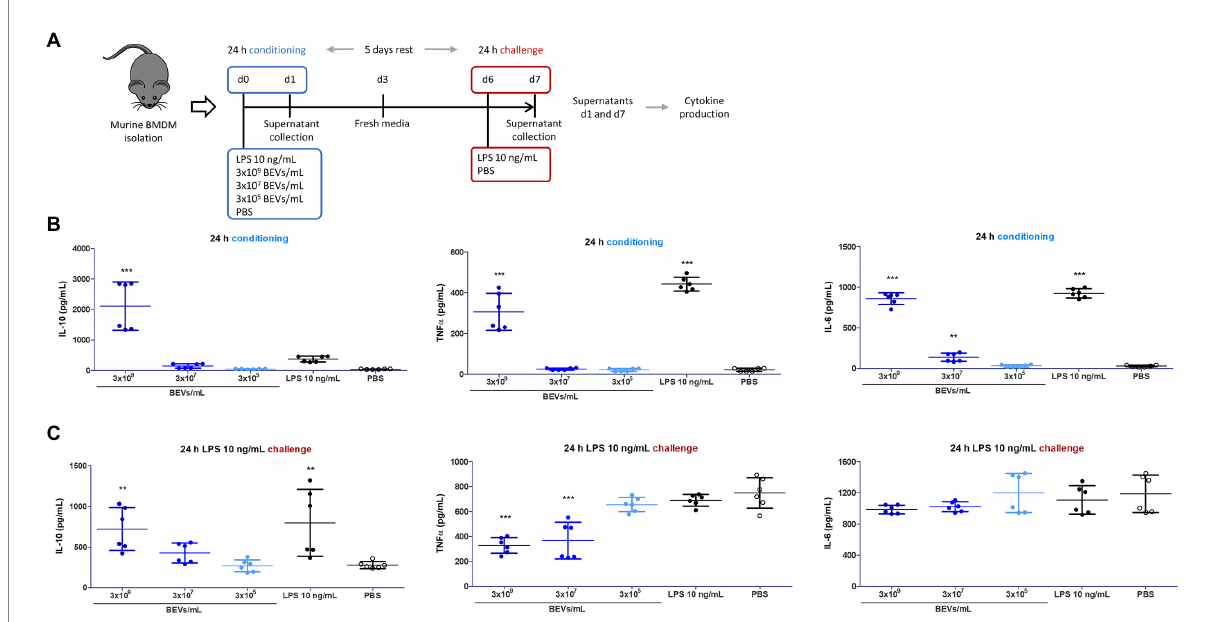
FIGURE 2 Bt BEVs modulate the production of anti- and pro-inflammatory cytokines by murine bone marrow derived macrophages (BMDM). (A) Experimental plan. (B) Cytokine production by BMDM 24 h after conditioning with Bt BEVs and LPS was assessed by ELISA. (C) Cytokine production by Bt BEV- and LPS-conditioned BMDM 24 h after exposure to LPS (10 ng/ml) determined by ELISA. Non-conditioned BMDM (PBS) were used as the reference group for statistical analysis. Graphs depict mean ± SD values. **p < 0.01; *** p <